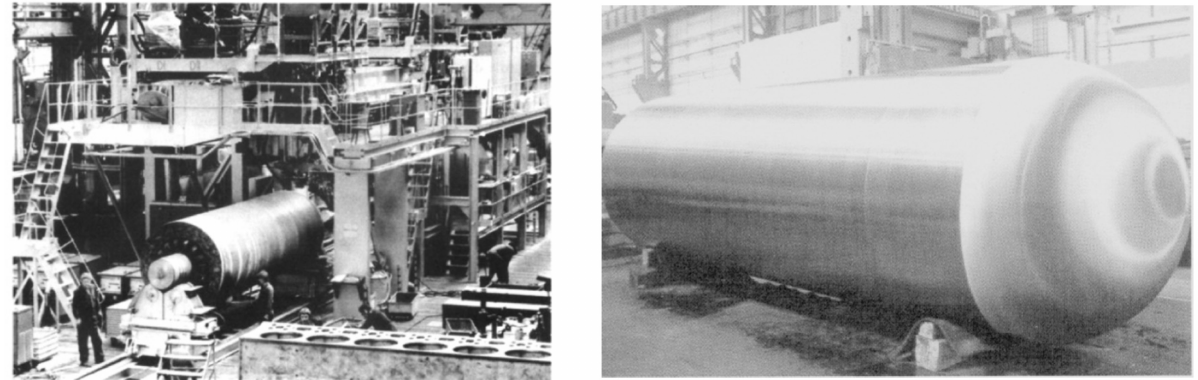
Figure 3. ( Left ) Welding equipment for shape welding up to 80 t (Thyssen factory picture) [11]. ( Right ) Shape welded reservoir of 72 t. Material: 10MnMoNi55 (Thyssen factory picture) [11].